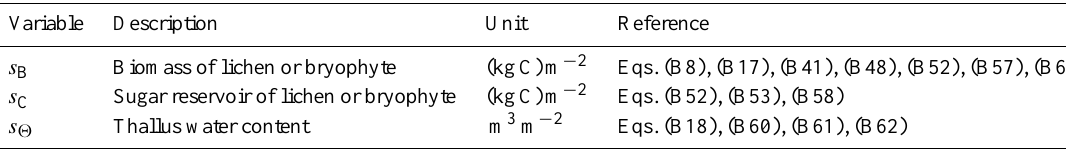
Table B14. State variables of lichens or